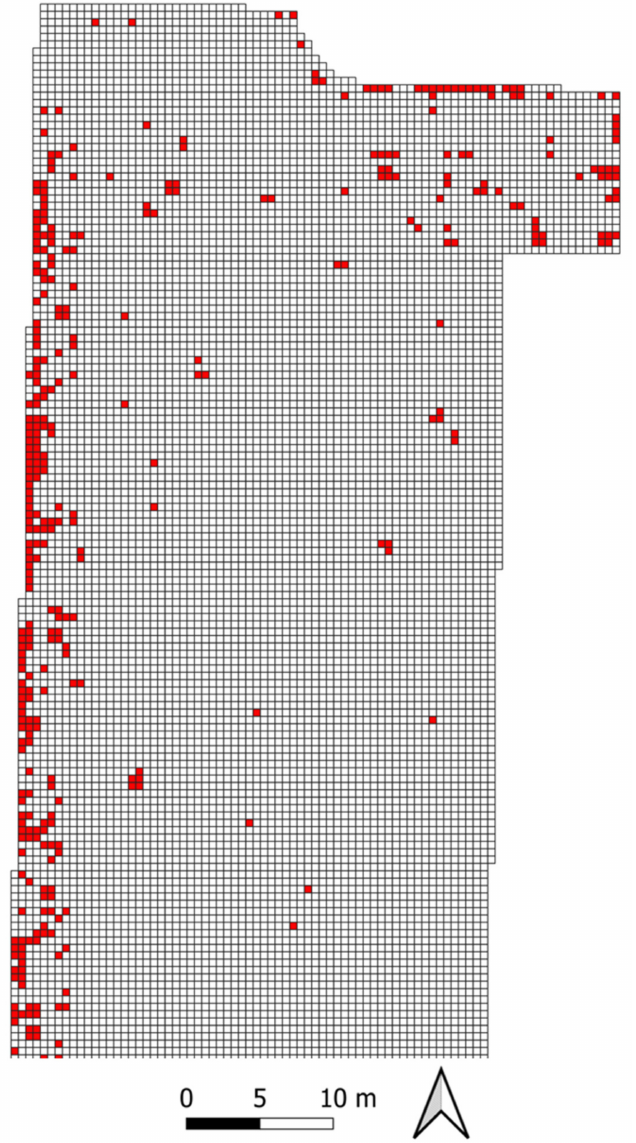
Figure 10. Detail of the northernmost part of the prescription map obtained by the ANN method with a threshold on the percentage of infested area per cell equal to